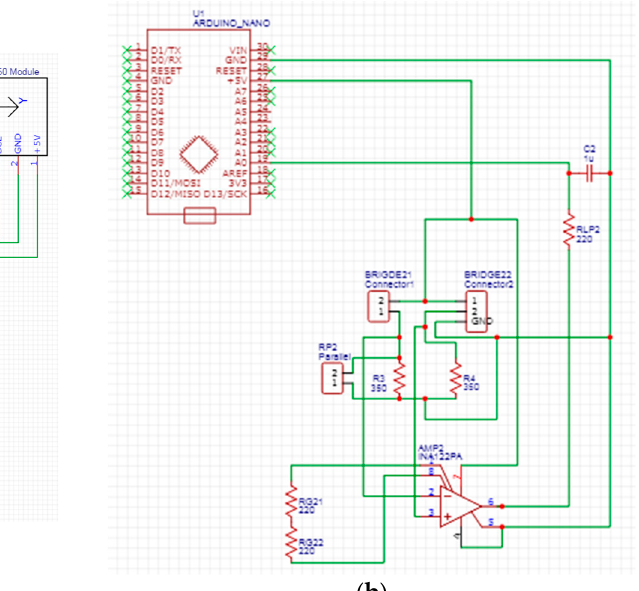
Figure 5. Gauges positioning in the different pedal areas. ( a ) Wheatstone bridge 1. ( b ) Wheatstone bridge 2. ( c ) Wheatstone bridge 3.